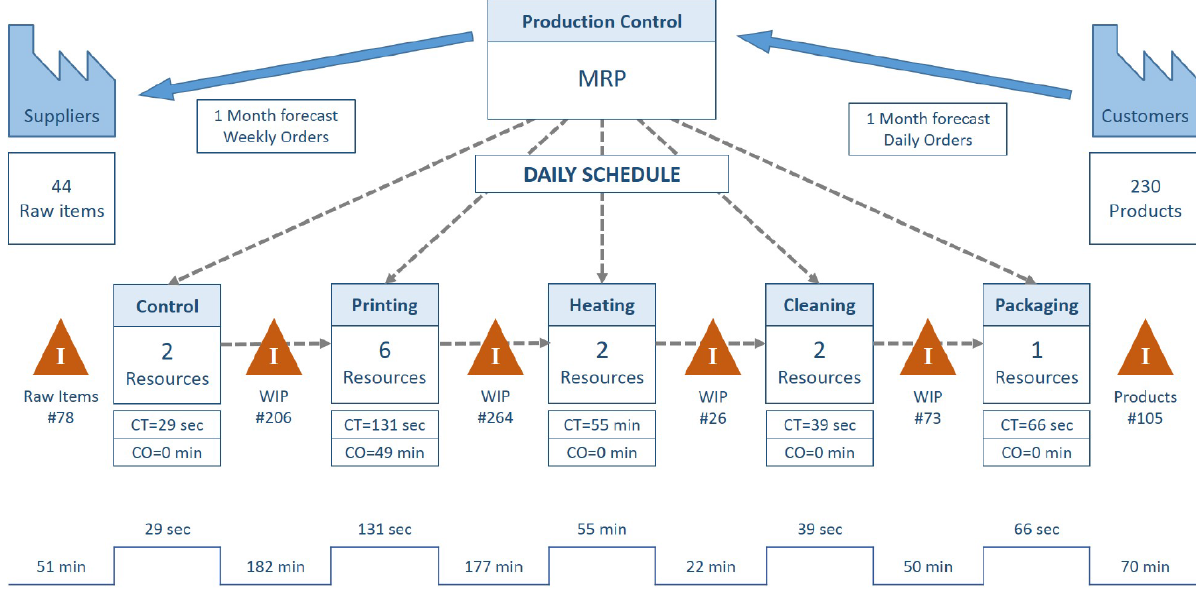
Figure 2. VSM Design Point: #1 Current State Map